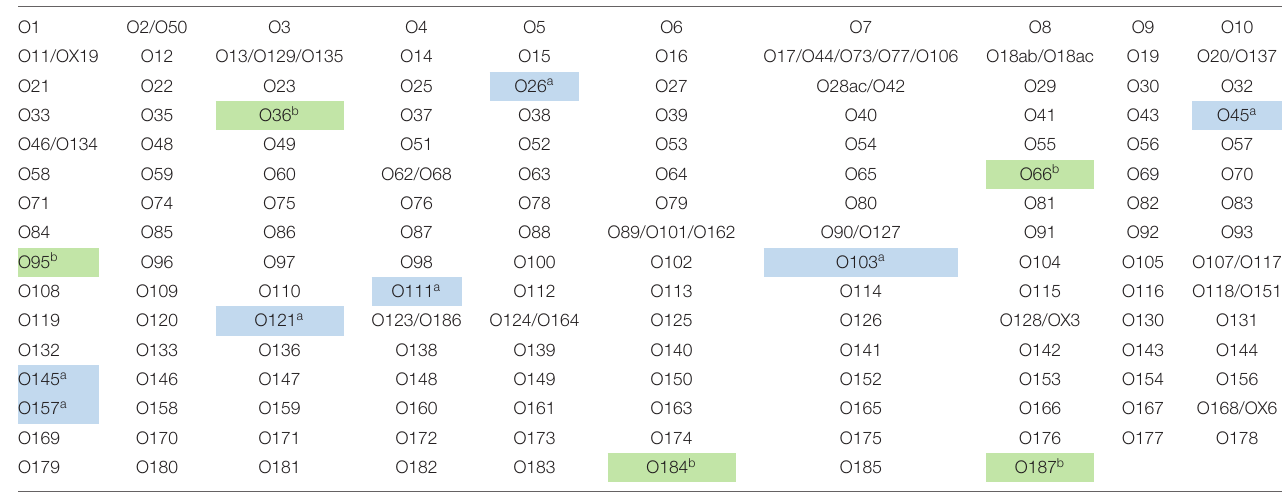
TABLE 1 | Serogroups that belong to the Shiga toxin-producing Escherichia coli